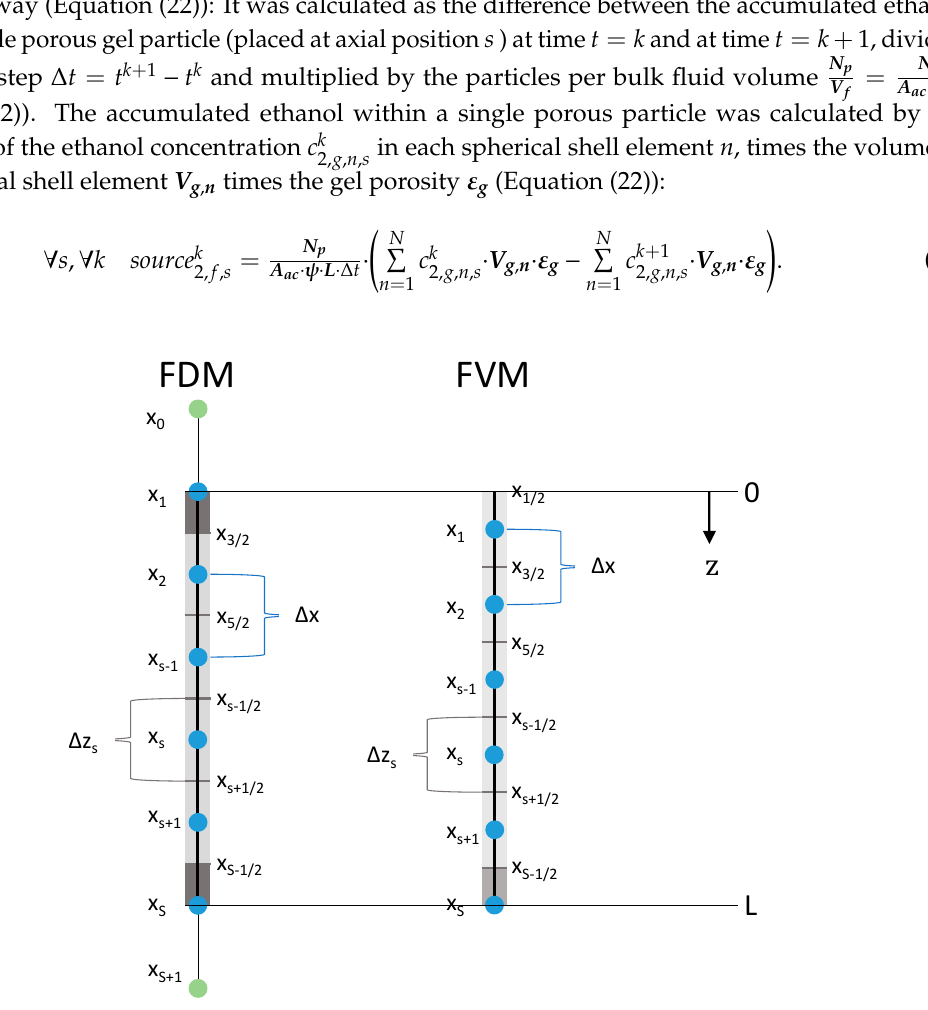
— cell —cell interface s + 1 2 (cid:3046)(cid:2878) (cid:3117) (cid:3118)